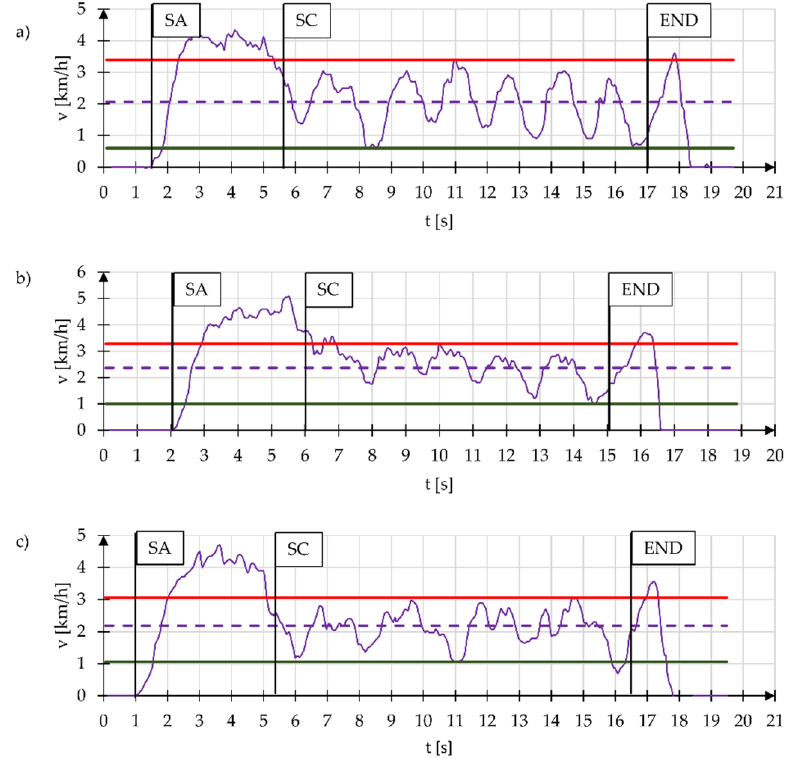
Figure7. SpeedwaveformsofawheelchairfortheTorqueAmplificationMode(t4)withtheamplification Figure 7. Speed waveforms of a wheelchair for the Torque Amplification Mode (t4) with the coe ffi cient w = 50% for subject 1 ( a ), subject 2 ( b ) and subject 3 ( c ). amplification coefficient w = 50% for subject 1 ( a ), subject 2 ( b ) and subject 3 ( c ).